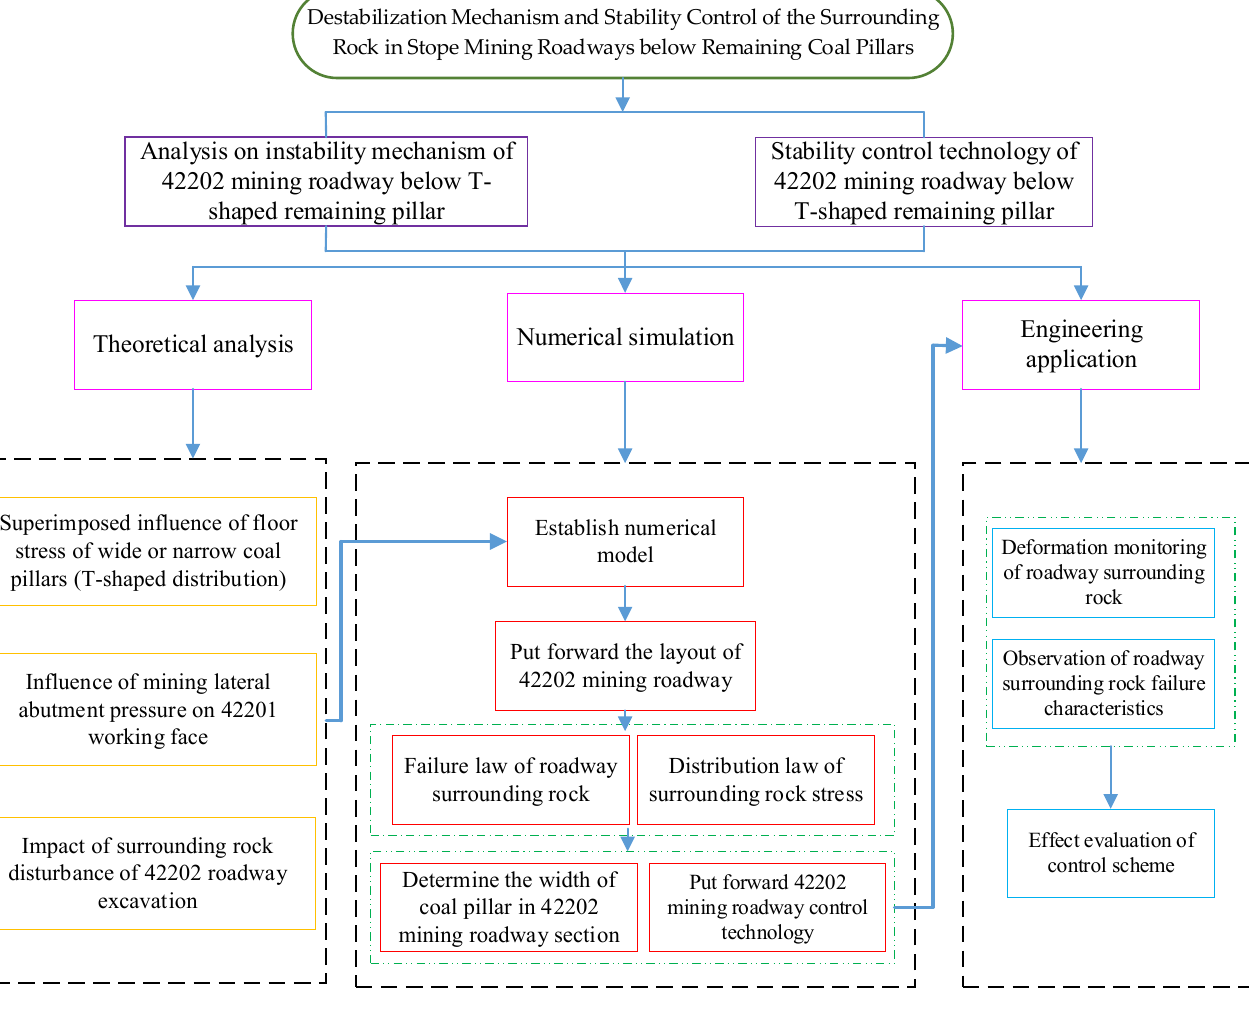
Figure 3. Flowchart of the research procedure.